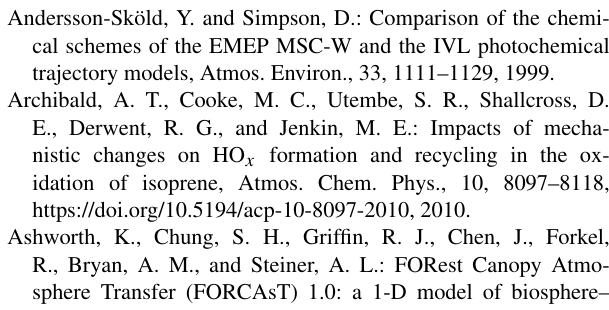
Figure 15. Selected lines from the output file CM_EmisFile.inc